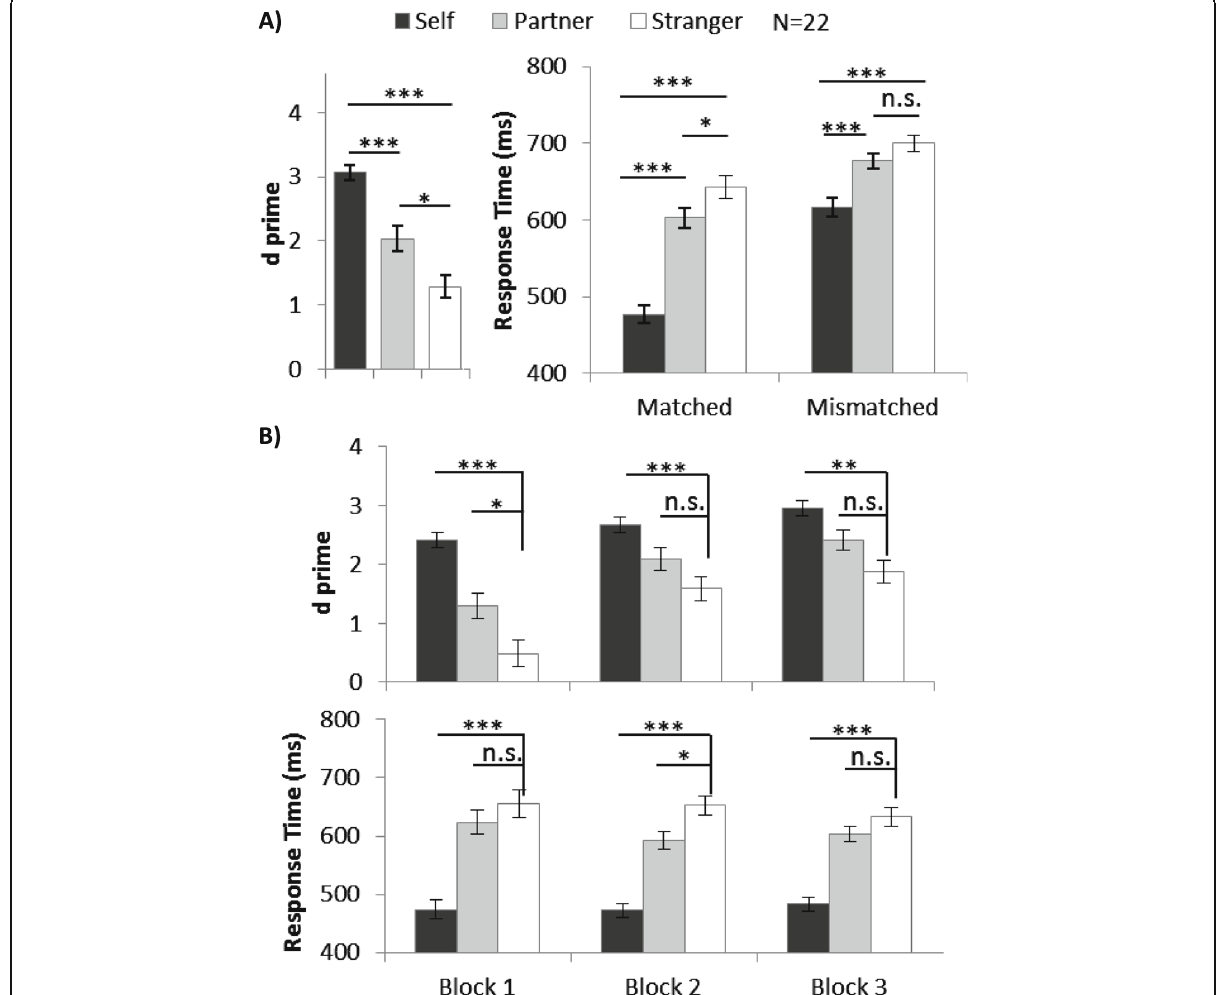
Fig. 2 a Mean and SE of d prime ( d ’ ) and response time (RT) for different shape categories in experiment 1. b Mean and SE of d ’ and RT (matched trials) for different shape categories for each block in experiment 1 (* p < .05, ** p < .01, *** p < .001). n.s., not